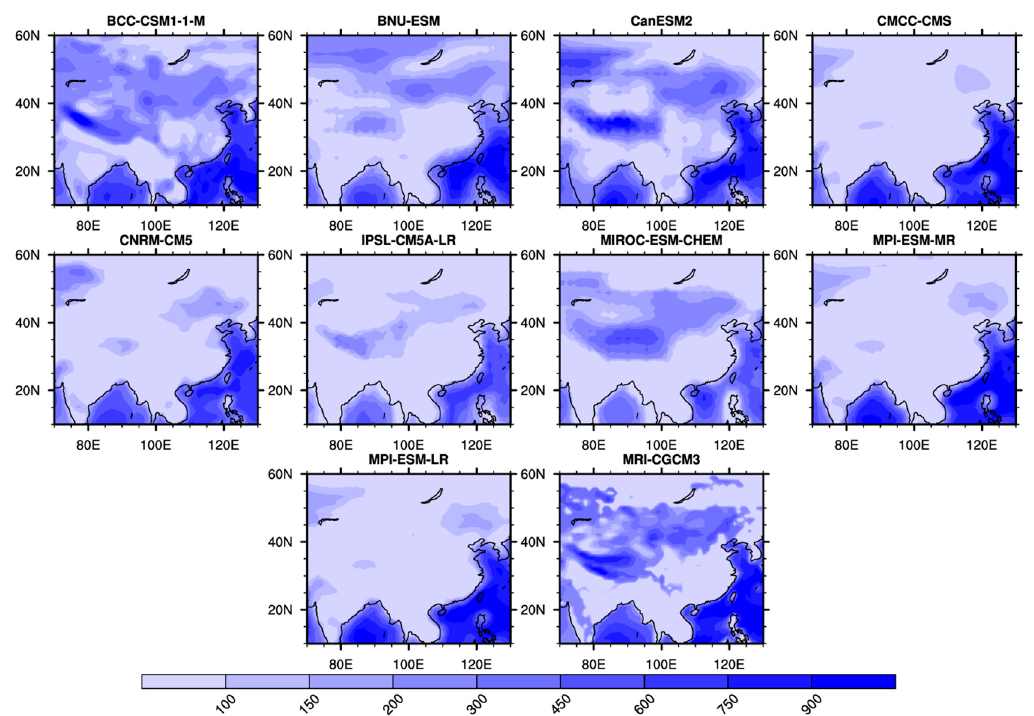
Figure A3. Spatial distribution of projected mean wind power density (WPD) in W / m 2 based on 90 m above ground level extrapolated wind speed for the 2021–2040 for the CMIP5 models under RCP8.5